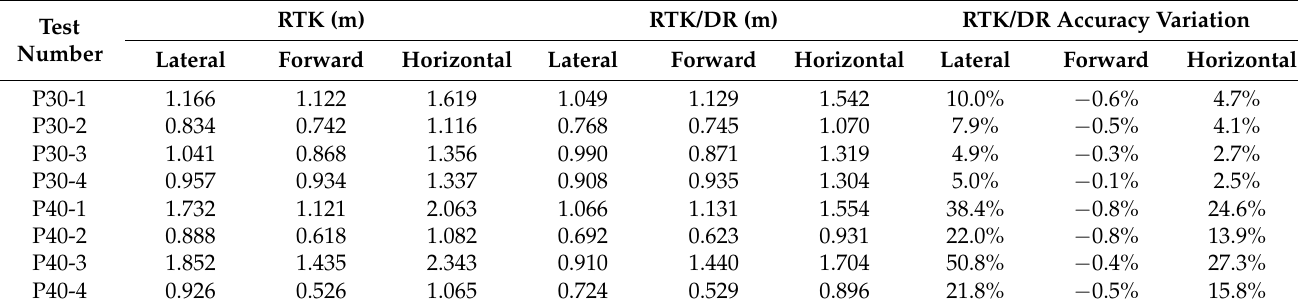
Table 3. Statistics of positioning error RMS.